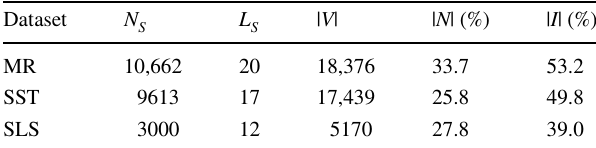
N L S number of sentences, S average sentence length, | V | vocabulary size, | N | percentage of documents with negative words. | I |, percentage of documents with intensive